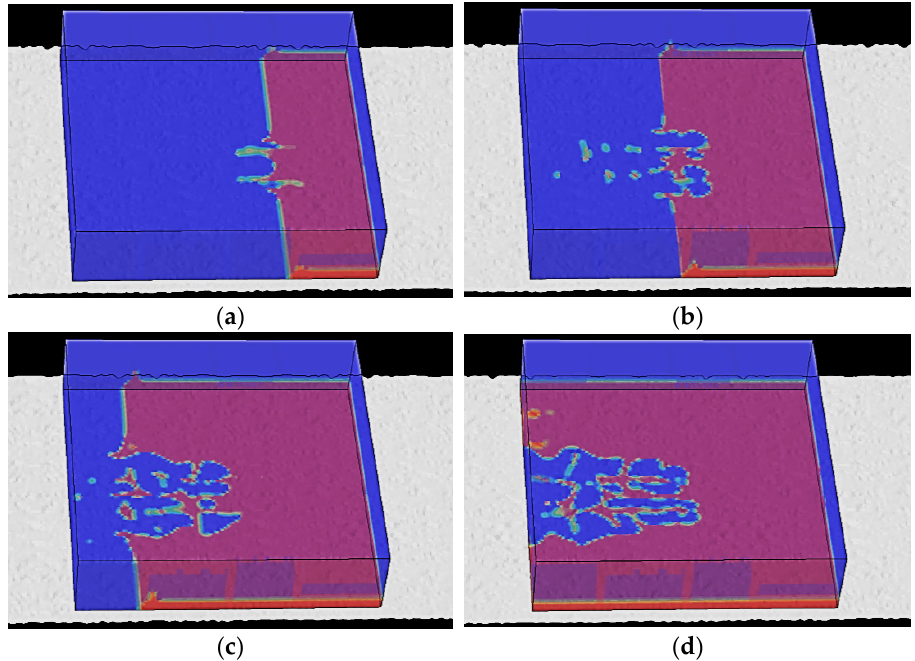
Figure 17. Flow trace in the tire aquaplane process. ( a ) t = 0.0060 s; ( b ) t = 0.0105 s; ( c ) t = 0.0165 s; ( d ) t = 0.0225 s.